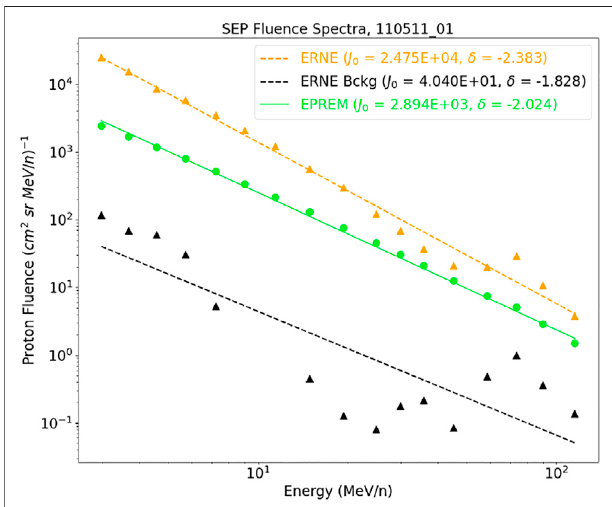
FIGURE12 | Acomparison between themodeled (green) and observed (yellow) proton fl uences for the event. The pre-event background ERNE spectrum is also shown with black symbols. Power law fi t amplitudes and indices for all fl uence spectra are shown as well.